Question: Describe this figure in one sentence.
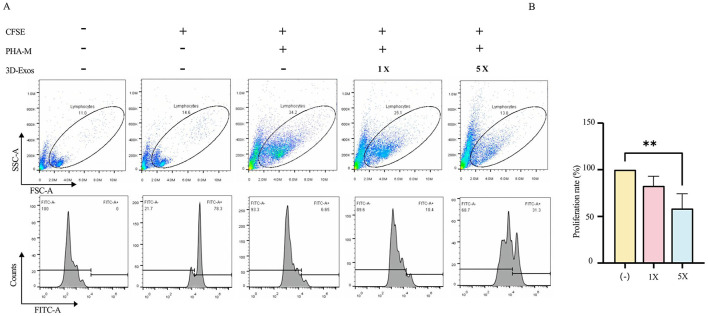
Answer: Inhibitory effect of 3D-EVs on lymphocyte proliferation. (A) Representative flow cytometry plots of human PBMCs stimulated with PHA-M and treated with 3D-EVs at concentrations of 1x10 9 particles/ml or 5x10 9 particles/ml. (B) Quantification of lymphocyte proliferation rates after treatment with 3D-EVs. The signals were captured by Flow cytometry and data were processed by FlowJo. ** p < 0.01.